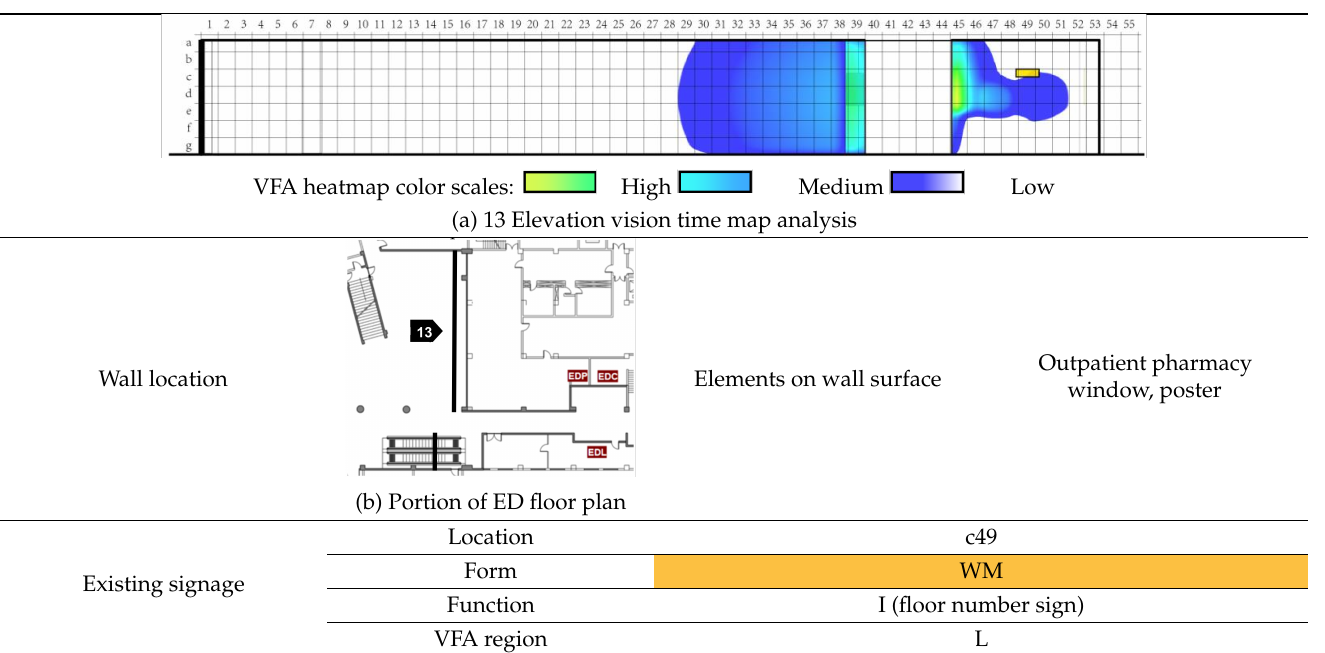
Table 17. 13 Elevation comparative